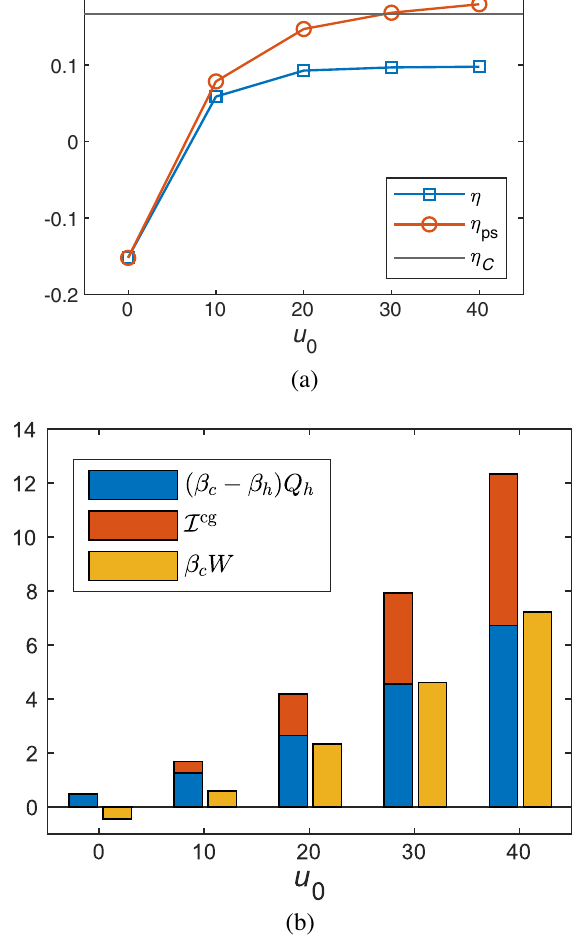
FIG. 9. Results for numerical model. (a) Efficiency (blue squares) and pseudo-efficiency (red circles), as a function of the reference active speed u 0 ¼ u h . Error bars calculated from the standard deviation with our data are not larger than the size of the points in the figure. (b) The quantities β c W , I cg , and ð β c − β h Þ Q c